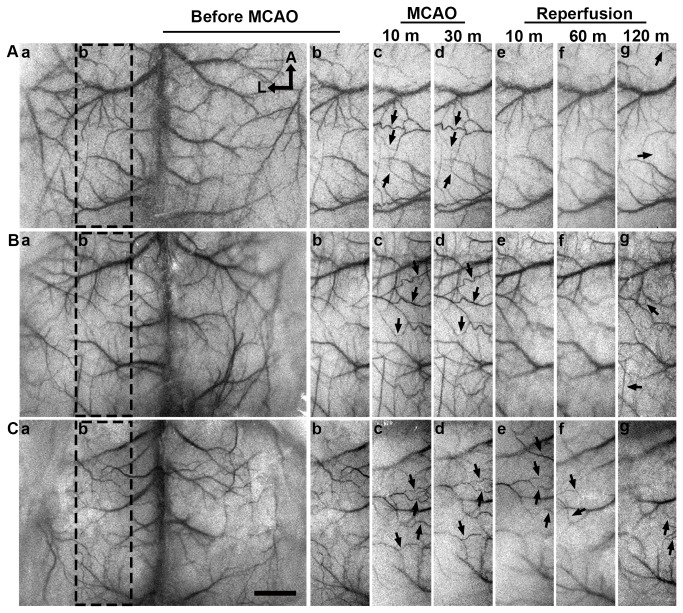
Cortical collateral circulation after tMCAO detected by LSCI.Cortical collateral circulation opened after tMCAO in successfully reperfused heparin-free mice (A) and heparin-treated mice (B). LSCI before MCAO (a-b) showed a clear cortical vascular morphology. Collateral arteries opened at 10 (c) and 30 minutes (d) after reperfusion. Collateral arteries were missing at 10 (e) and 60 minutes (f) after reperfusion. Notably, collateral arteries opened again at 120 minutes after reperfusion (g). (C) Collateral circulation after tMCAO in heparin-free mice with failed reperfusion. LSCI before MCAO (a-b) showed a clear cortical vascular morphology. Collateral arteries opened at 10 (c) and 30 minutes (d) after suture withdrawal. Collateral arteries were still open at 10 (e), 60 (f) and 120 minutes (g) after suture withdrawal. Broken Circle indicates the selected areas of images b to g. Arrows indicate the collateral artery. Bar= 1 mm. A: anterior, L: left, LSCI: laser speckle contrast imaging, tMCAO: transient middle cerebral artery occlusion.